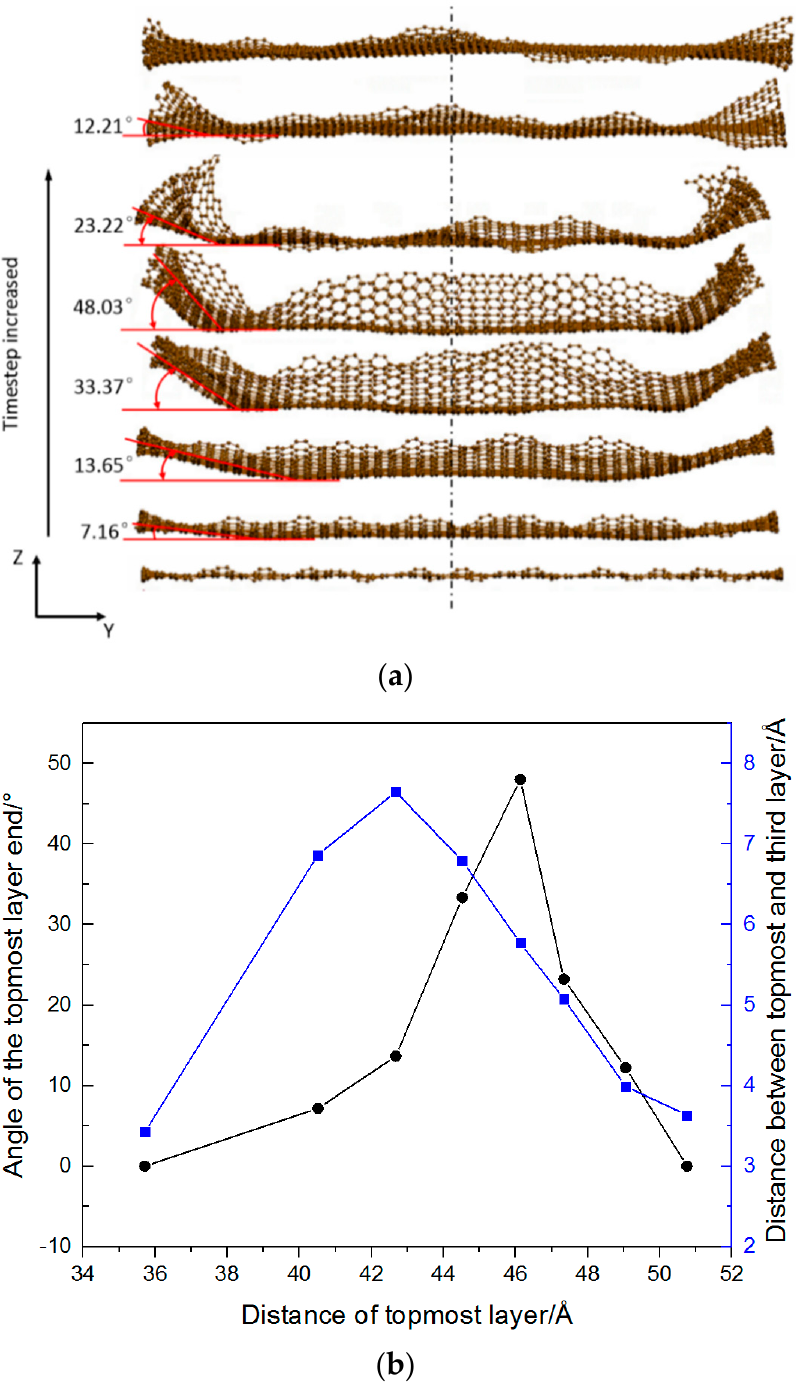
Figure 8. The topmost layer of the four-layer graphene system curled symmetrically on the X -axis. ( a ) The snapshots of the topmost layer at different times; ( b ) The angle of the topmost layer’s end varies with the distance of the topmost layer and the distance between the topmost layer and the third layer.